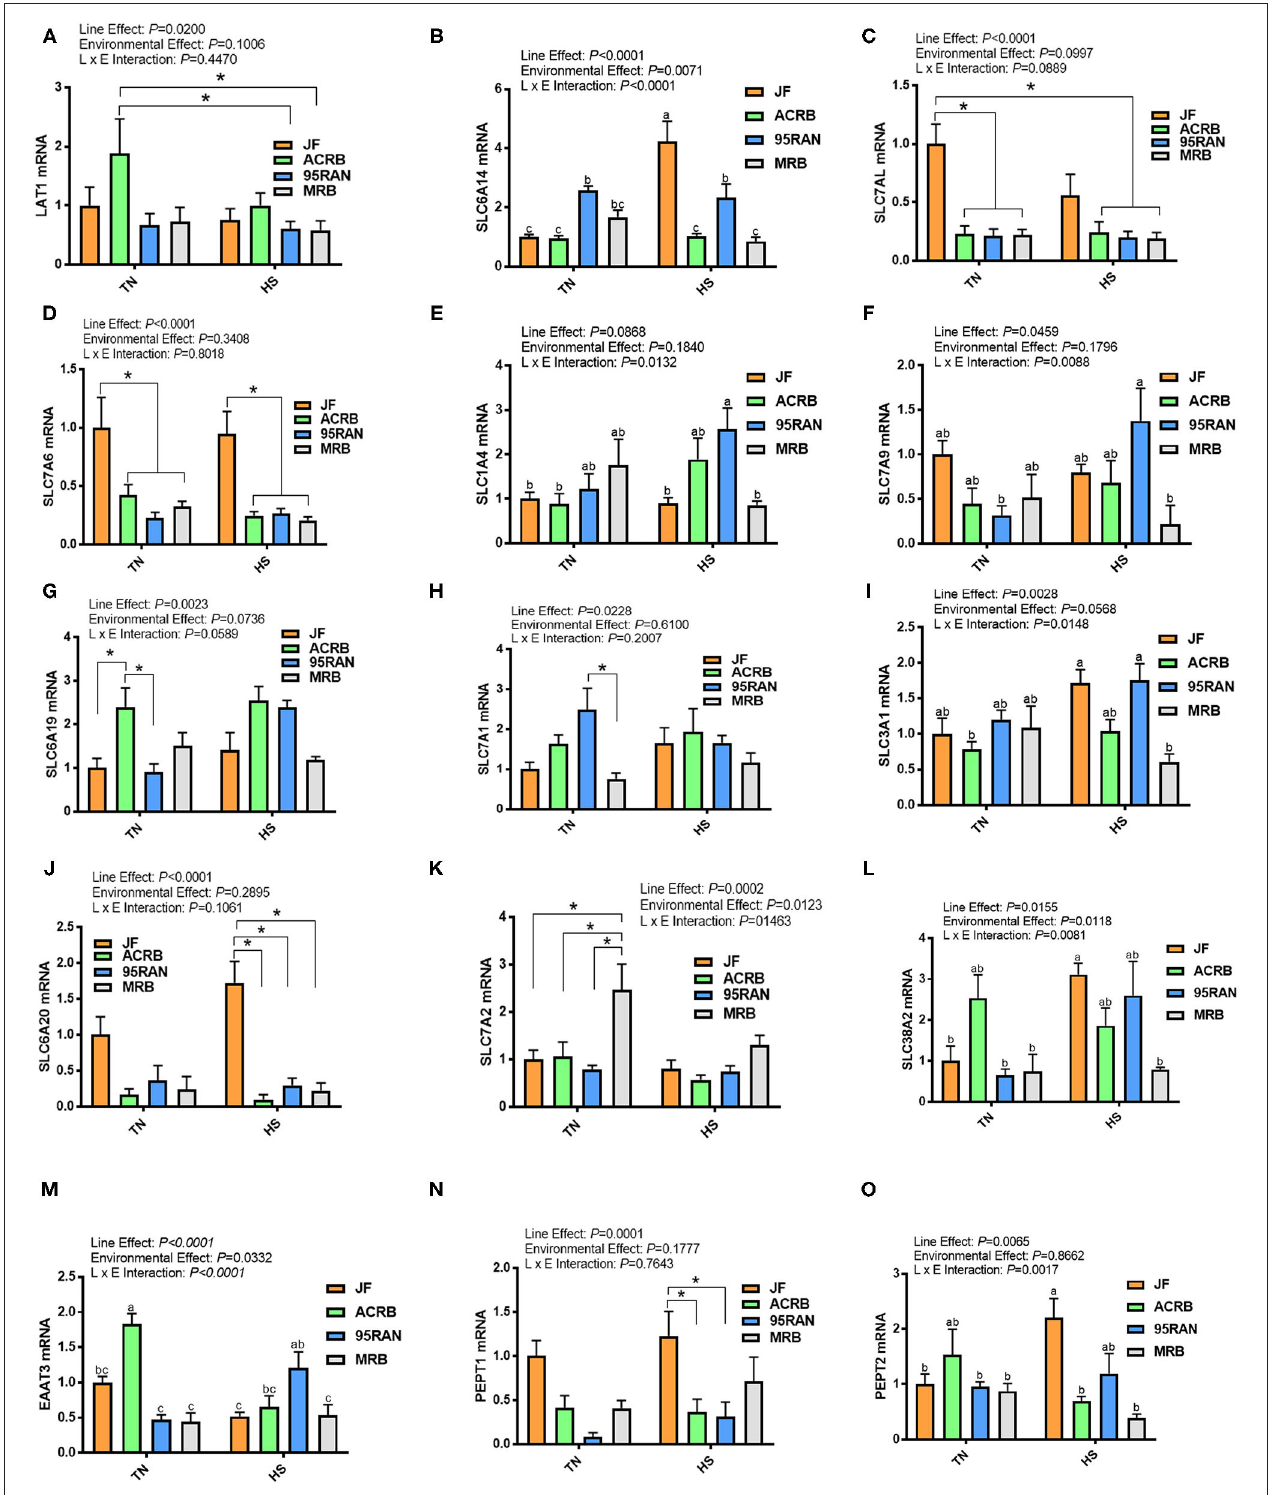
FIGURE 7 | Amino acid transporter gene expression in the jejunum of JF, ACRB, 95RAN, and MRB birds under TN and HS. (A–O) RNA was extracted from tissue and analyzed by qPCR. Gene expression data are mean ± SEM ( n = 6/group). * and different letters indicate a significant difference at P < 0.05. LAT1, L-type amino acid transporter 1; EEAT3, excitatory amino acid transporter 3; PEPT, peptide transporter; SLC, Solute carrier family; HS, heat stress; TN, thermoneutral; JF, jungle fowl; ACRB, Athens Canadian Random Bred; 95RAN, 1995 random bred; MRB, modern random bred.